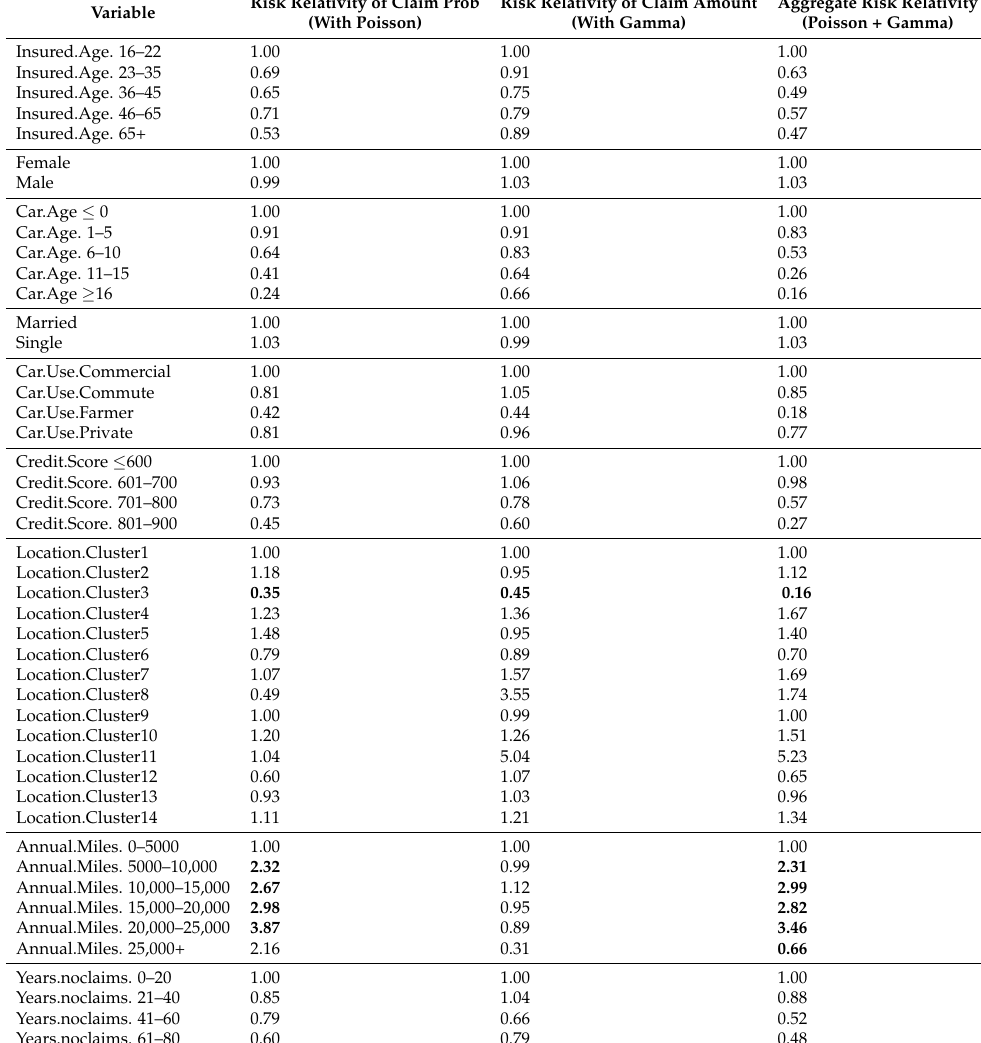
Table 9. Risk relativity estimate for categorical factors and numerical factors with designed levels.